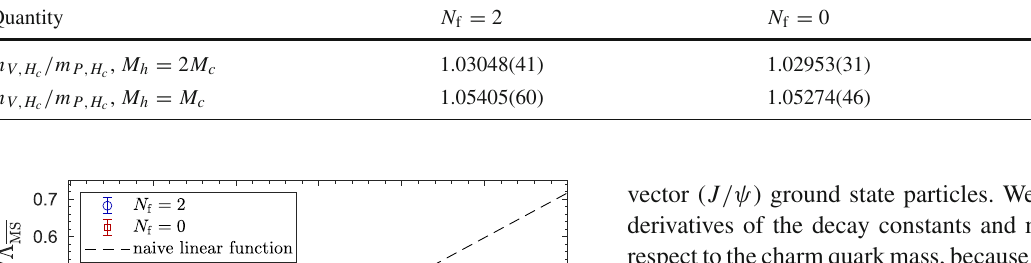
Table 5 Results for m V , H from Ref. [12] Quantity